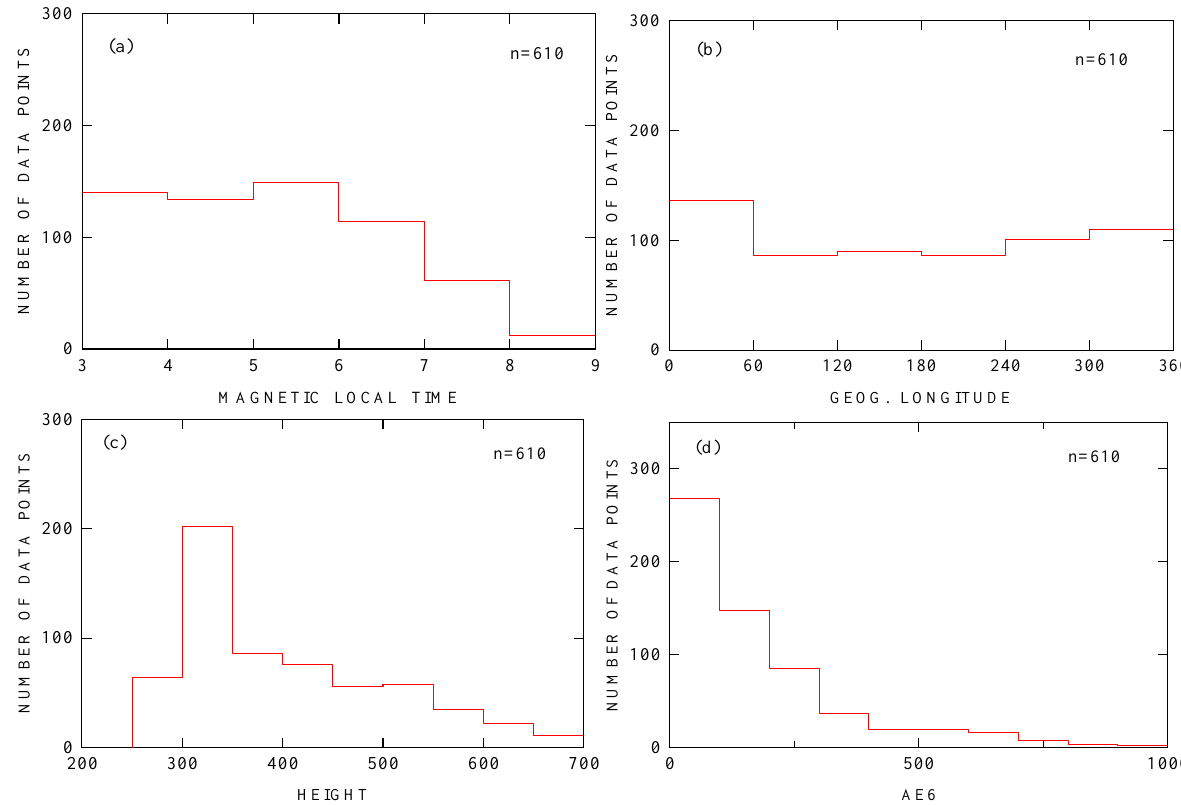
Fig. 2. Statistics of the data set analyzed in the present study. (a) Histogram indicating the magnetic local time distribution of the 610 electron density profiles parameterized. The time is given in hours. (b) Histogram indicating the geographic longitude distribution of the data set. The longitude is given in degrees east. (c) Histogram indicating the height distribution of the data set. The height is given in kilometers. (d) Histogram indicating the magnetic activity distribution of the data set. As a measure of this activity we use the AE6 index defined in Eq. (1). The units of this index are